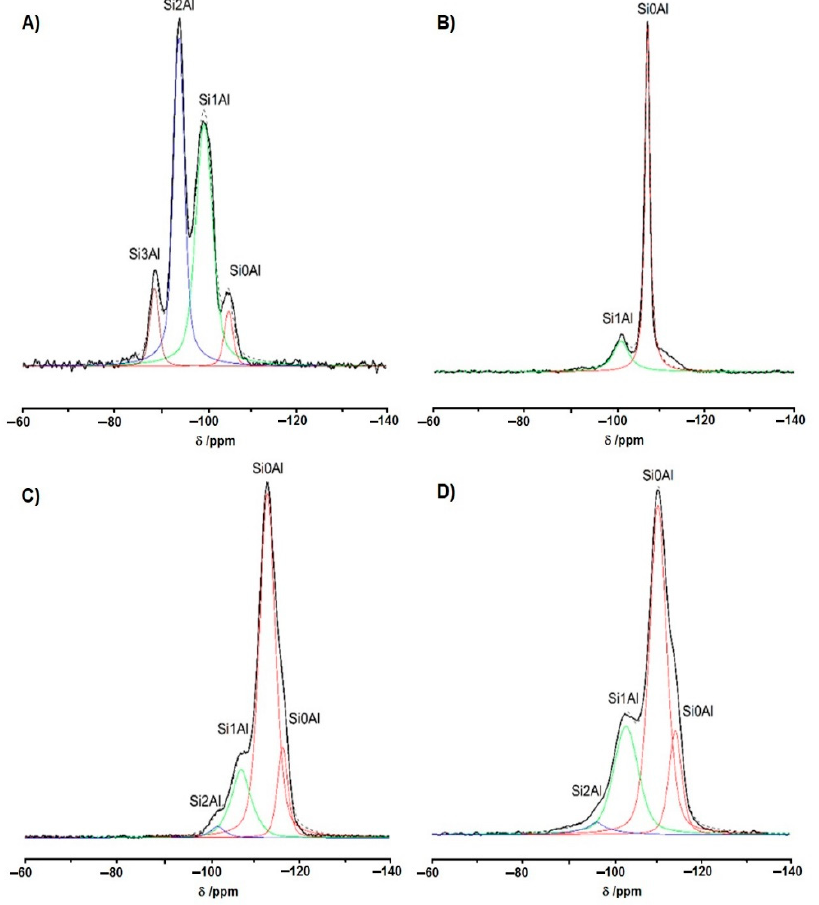
Figure 4. The 29Si MAS NMR spectra of zeolites NaY ( A ), HFAU ( B ), HMFI ( C ), and HBEA ( D ). The spectra are normalized to the same intensity of the highest signal.